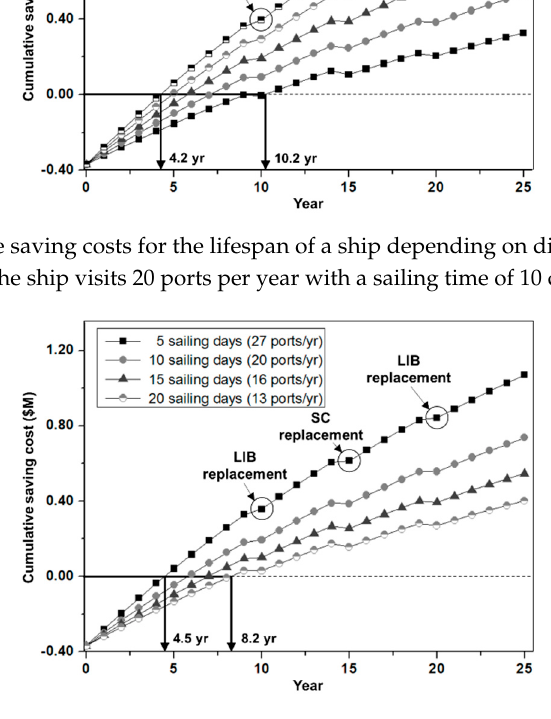
Figure 15. Cumulative saving costs for the lifespan of a ship depending on different sailing times (assuming that the ship stays at a port for 200 h with a cargo handling time of 120 h ).